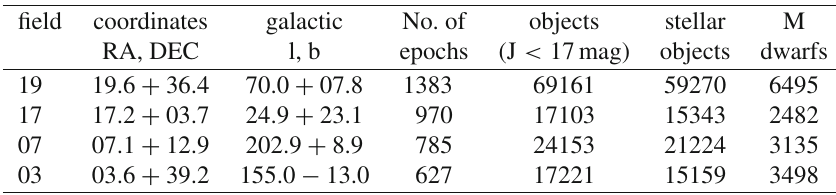
Table 1. WTS fields and number of epochs taken up to November 2012. Thenumber of stars is also listed (brighter than J = 17mag) altogetherwith the number of M dwarfs (more details in Section 2).